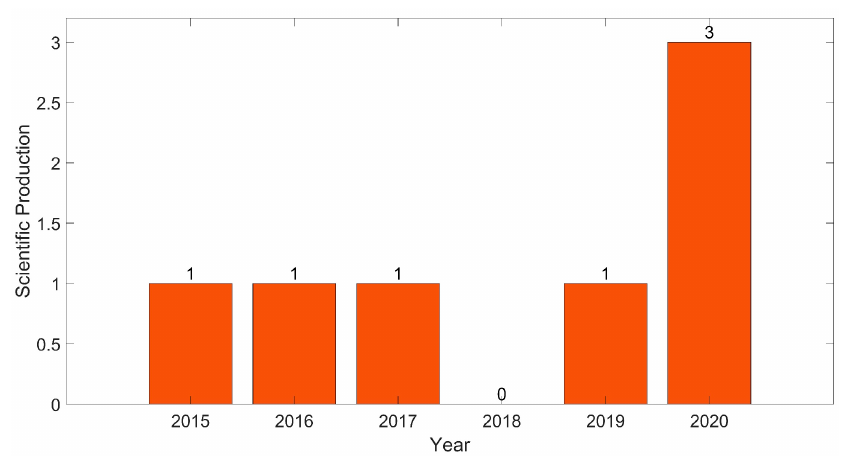
Figure 3. Number of scientific productions between 2015 and 2020, searched in all fields, for the keywords “cyber-physical system” and “artificial intelligence” and “chemical engineering”.